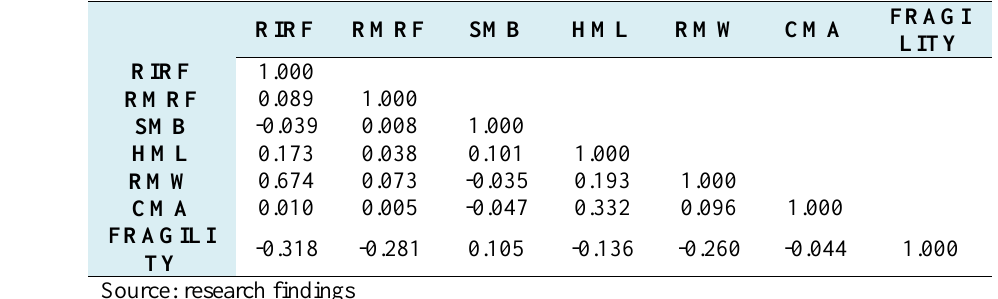
Table 5. Value of correlation coefficient